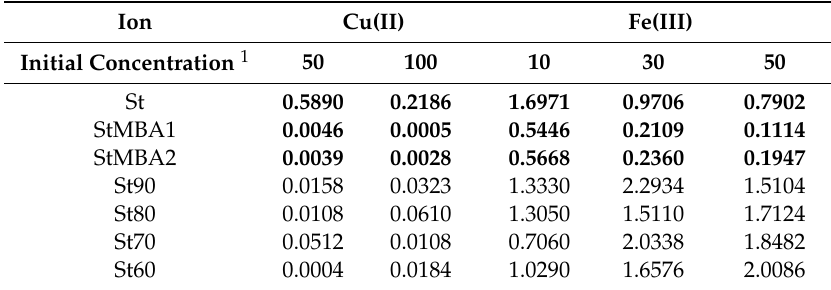
Table 4. The second order rate coefficient “k” from pseudo-second order mathematical model (determined from the slope and intercept of a plot of t/AE t against t) of St, StMBA1, StMBA2 and starch SAPs with different amount of natural polymer for Cu(II) and Fe(III) adsorption from different initial concentration of ions solutions.